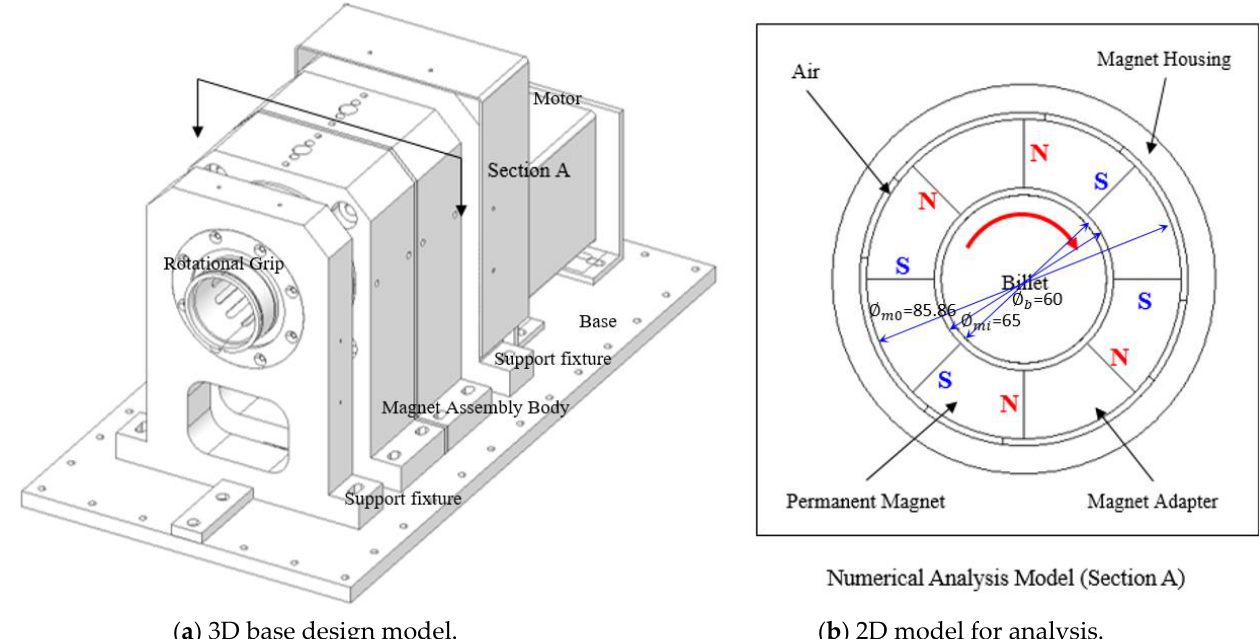
Figure 2. Geometric diagram of permanent magnet-based billet induction heating.